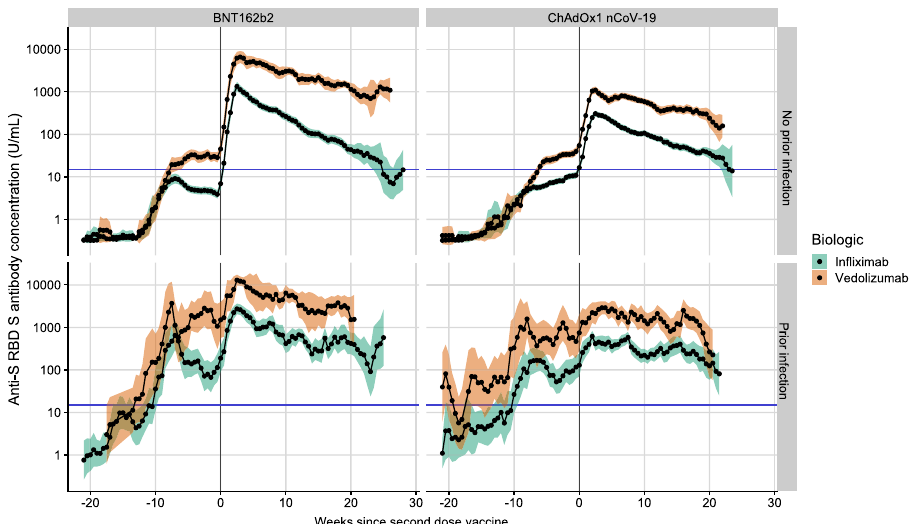
Fig. 5 Rolling geometric mean antibody concentration over time from the date of the second dose of the SARS-CoV-2 vaccine (week 0) strati fi ed by biologic therapy (in fl iximab vs vedolizumab), vaccine and history of prior SARS-CoV-2 infection. Geometric means are calculated using a rolling 15-day window (i.e. 7 days on either side of the day indicated). The shaded areas represent the 95% con fi dence intervals of the geometric means. The horizontal blue line represents the seroconversion threshold (15 U/mL). The number of participants included at each time point is presented in Supplementary Fig. 2. Overall, data from 4474 participants with no history of prior infection (3029 on in fl iximab and 1445 on vedolizumab) and 1179 participants with a history of prior infection (833 on in fl iximab and 346 on vedolizumab) were included in this graph between 22 weeks before and 29 weeks after the second vaccine dose. The biologic treatment in fl iximab is shown in green and vedolizumab is shown in orange. Source data are provided as a Source Data fi le.